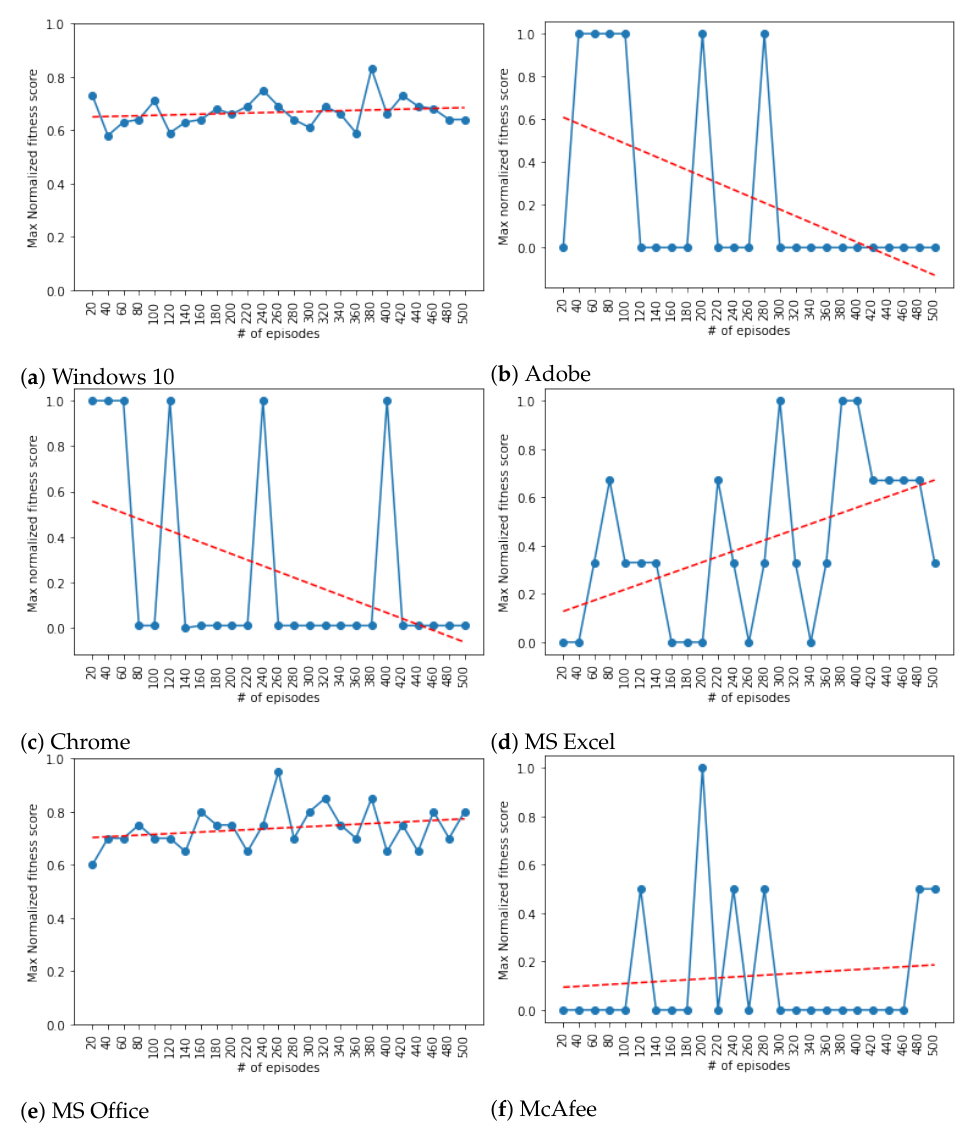
Figure 2. The fitness scores obtained for each number of episodes. Performance. To depict the trends of the fitness scores across the episodes, the plots are annotated (i.e., the red line) with fitted linear models. As Figure 2a–f indicate, we observe an increasing trends in fitness scores (most of cases) and overall good performance of generating secure configurations with very high fitness